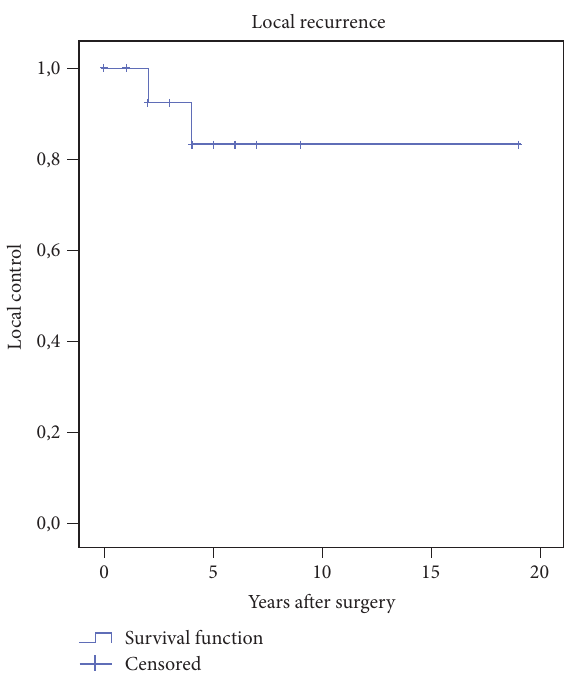
Figure 4: Kaplan-Meier cumulative survival curves for all patients under 16 years of age with giant cell tumor of bone (GCT) diagnosed and treated at our institution between 1984 and